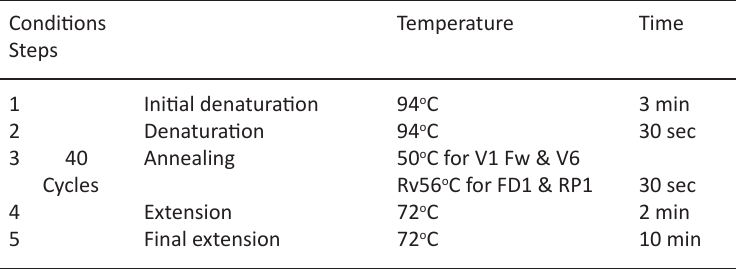
Table 1. The used thermal profile for the amplification of 16S rRNA gene by PCR.